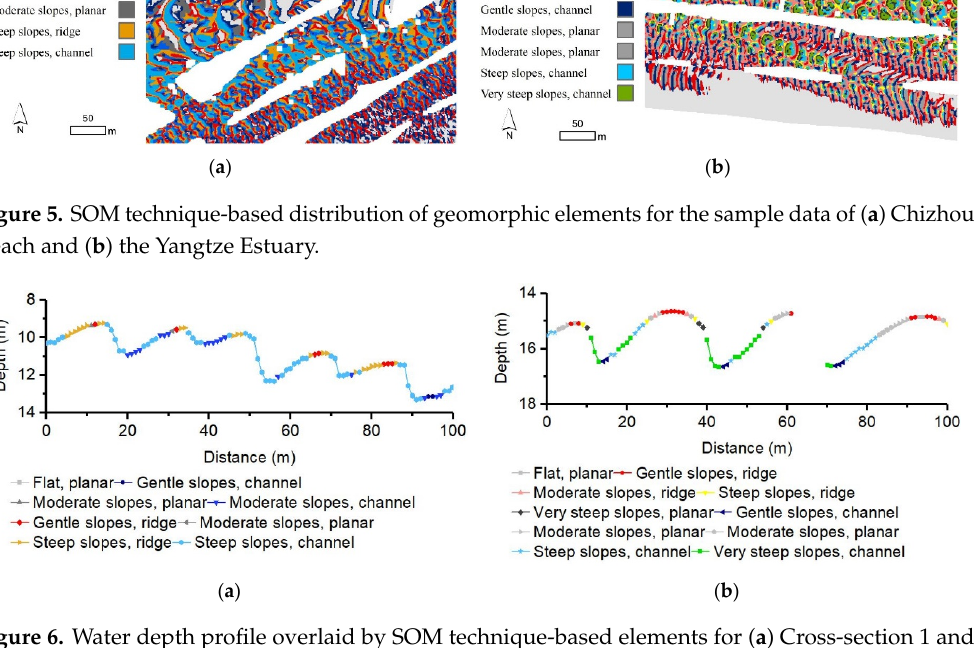
Figure 6. Water depth profile overlaid by SOM technique-based elements for ( a ) Cross-section 1 and ( b ) Cross-section 4.